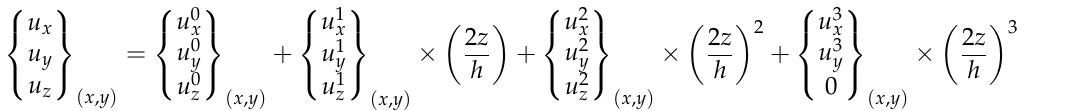
In the NE approximation, a uniform NEM grid is constructed on the mid-surface (cid:118) of the FG porous plate. Referring to a previous paper [27], the NEM grid consists of a finite number of grid points called nodes and Delaunay triangles. For the NE